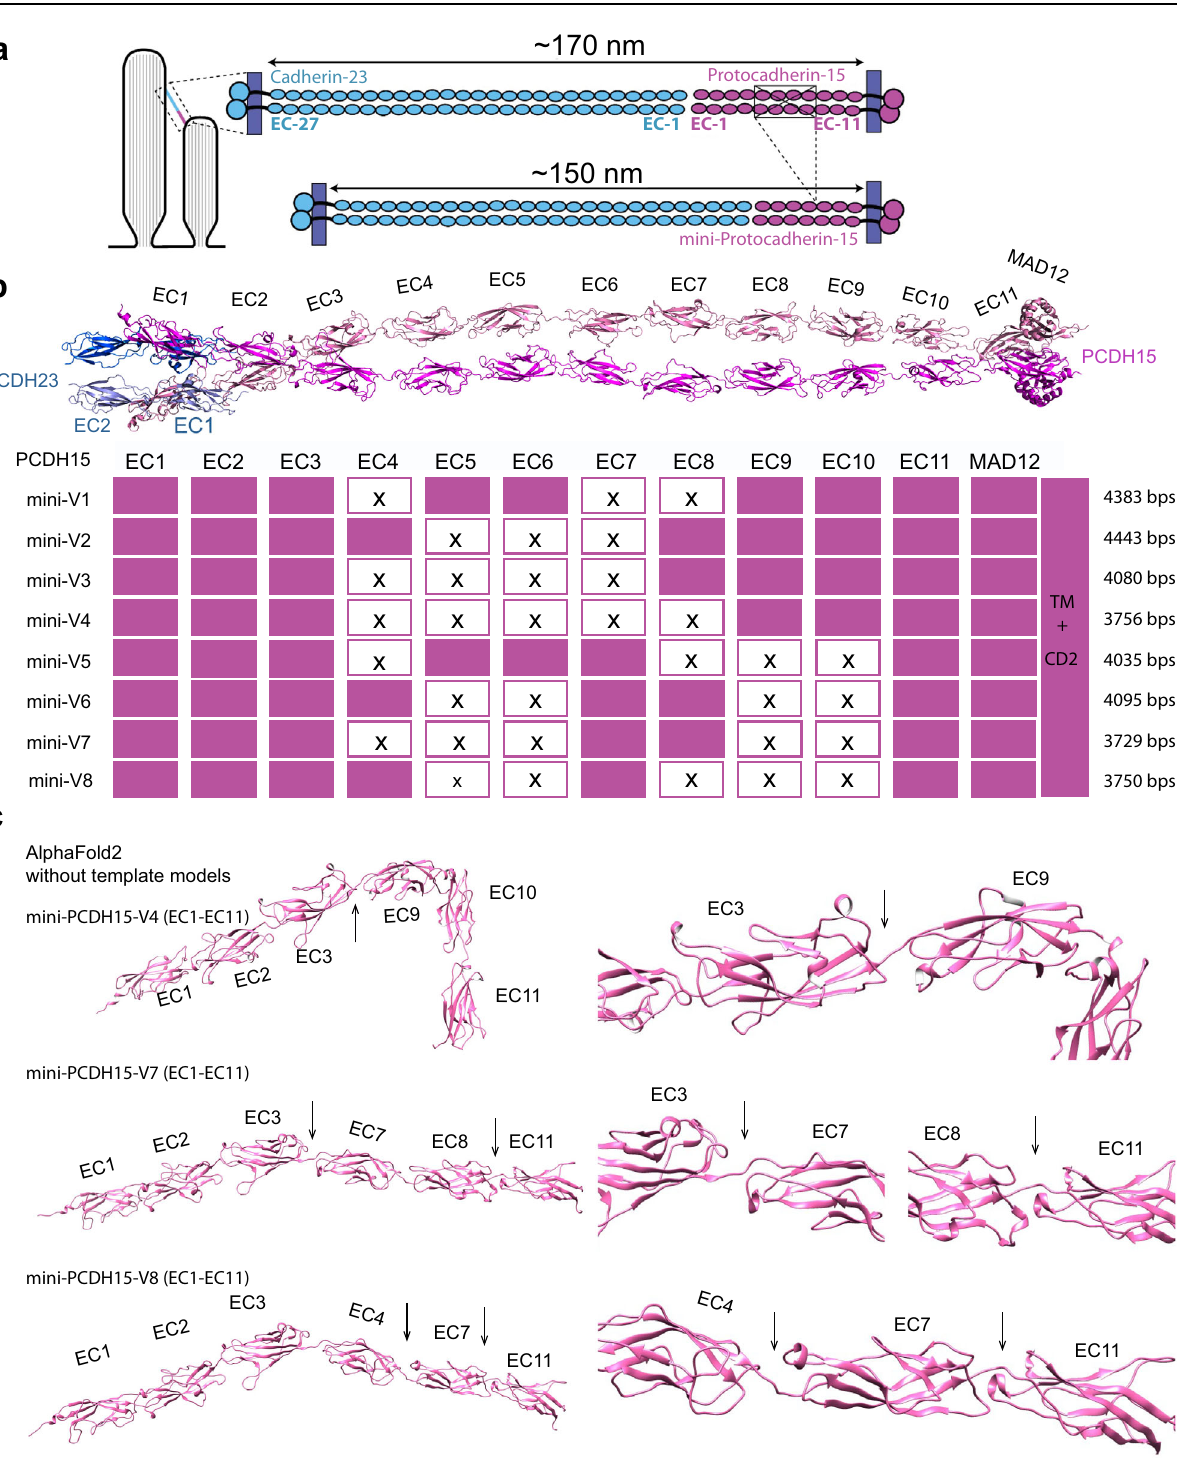
(blue; adapted from Choudhary et al., 2020). lower panel, The EC repeats deleted fromeachmini-PCDH15version. c AlphaFold2monomericstructuremodelsforthe three shortest mini-PCDH15s (V4, V7, and V8), calculated without utilizing a structural template. The predictions with or without a structural template are nearly identical. Right panels are higher magni fi cation images of the junctions between EC repeats